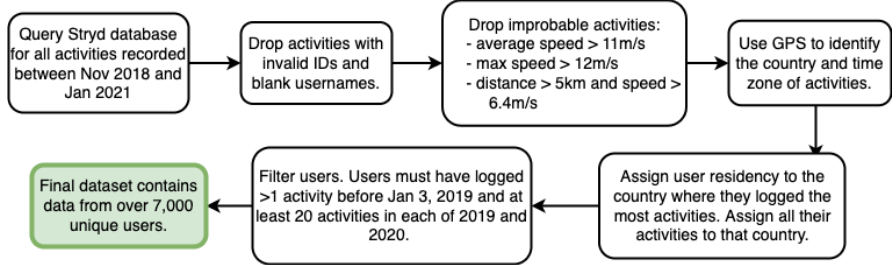
Figure 1. Overview of data cleaning